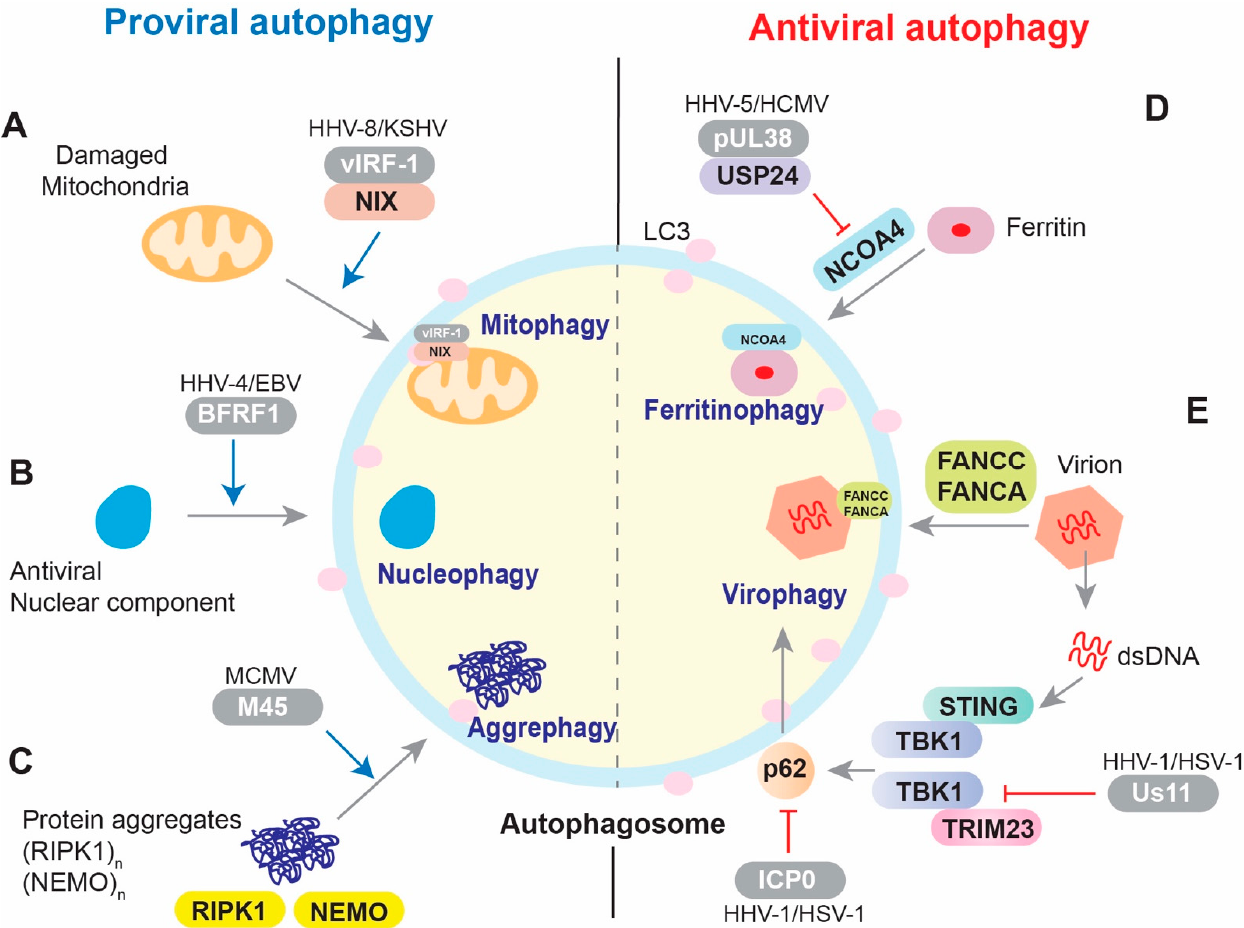
Figure 1. Overview of the regulation of selective autophagy by herpesviruses. ( A ) Mitophagy. HHV-8 vIRF-1 activates NIX-mediated mitophagy during lytic replication. ( B ) Nucleophagy. EBV BFRF1 promotes nuclear vesicle-mediated autophagy following reactivation. ( C ) Aggrephagy. MCMV M45 promotes the aggregation of RIPK1 and NEMO and then autophagic clearance of the aggregated proteins. ( D ) Ferritinophagy. HCMV pUL38 inhibits NCOA4-mediated autophagy by interacting with USP24, which destabilizes NCOA4. ( E ) Virophagy. The Fanconi anemia proteins FANCA and FANCC mediate autophagic clearance of HSV-1. In addition, p62/SQSTM1-mediated virophagy can be activated by TRIM23 or STING via TBK1 after HSV-1 infection. The ICP0 protein downregulates the autophagy receptor p62/SQSTM1 during the early stages of HSV-1 infection, and the Us11 protein excludes TBK1 from the TRIM23/HSP90 complex to inhibit autophagy-mediated restriction of HSV-1 infection. Viral proteins are highlighted within gray capsules.